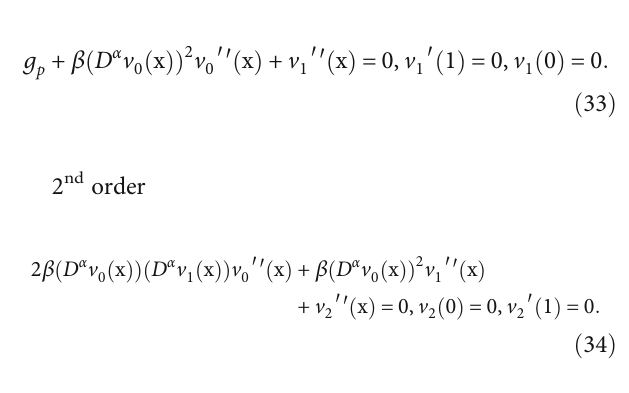
Figure 4: In lifting case e ff ect of increasing β and g where α = 0 : 8 is fi